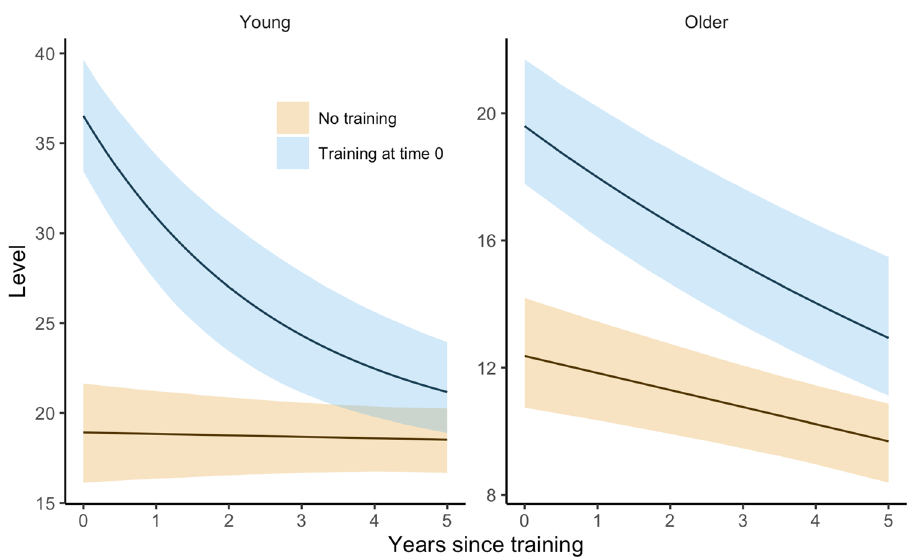
Figure 3. Estimated change in memory performance in the years following the